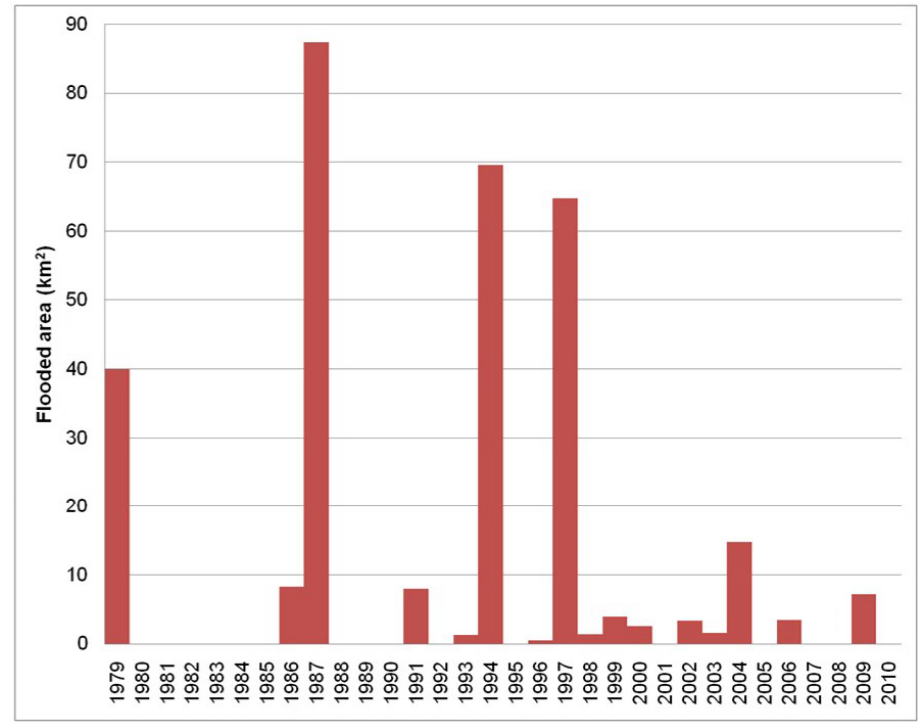
Figure 6. The monthly distribution of the flooded area during 1979–2010.